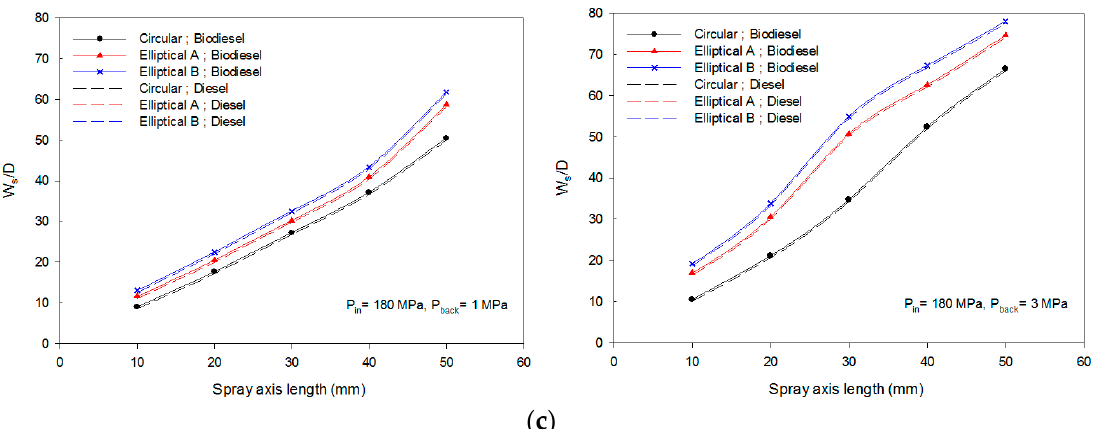
Figure 17. Ratio of spray width over nozzle hydraulic diameters ( a ) 50 MPa pressure injection; ( b ) 100 MPa pressure injection; ( c ) 180 MPa pressure injection.